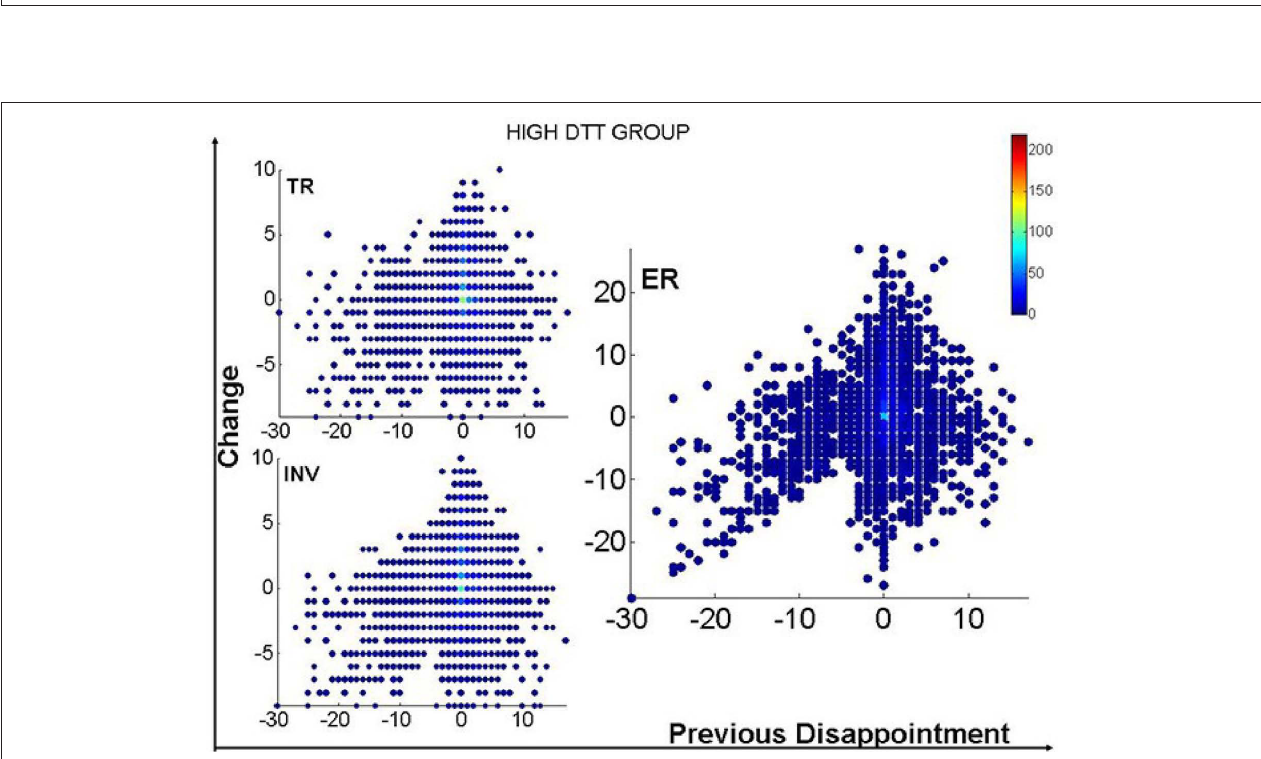
FiGurE A3 | Changes in Strategy as a function of previous disappointment for Low-DTT group. Change in the three variables under study as a function of the disappointment experienced in previous trial. TR stands for Trustworthiness Ratings, INV for the investment, and ER for the expected return (expectations). A tendency to raise the TR and ER after elation (great positive value on x -axis) is observed.